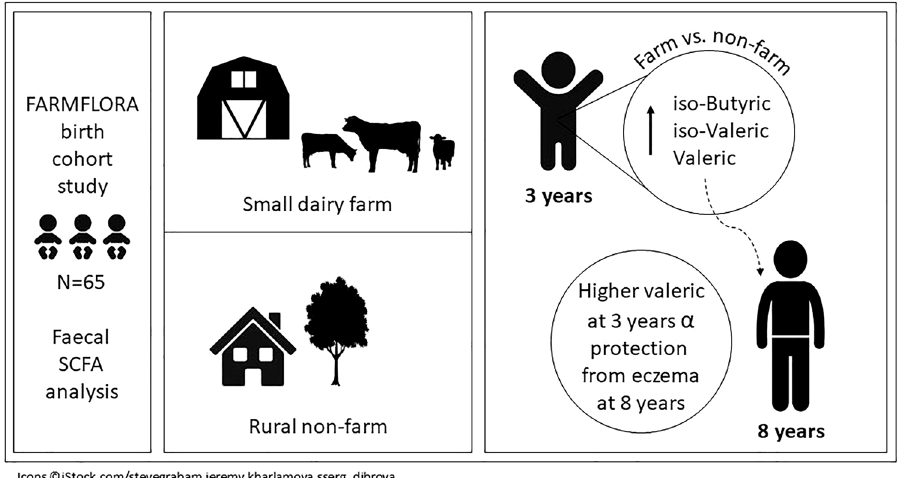
Figure 4. Overview of key